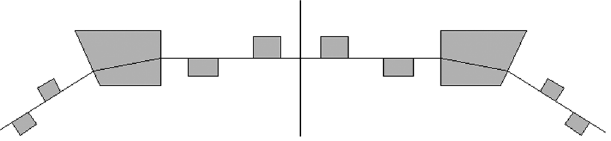
FIG. 2. Sketch of a symmetrical achromatic system. The trapezoids indicate bending magnets, and the rectangles indicate